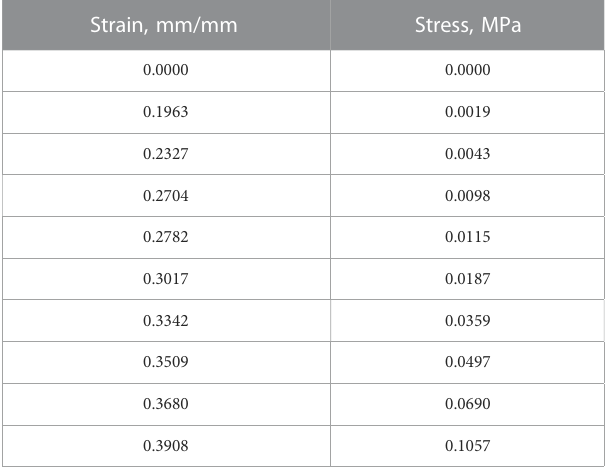
PDL: periodontal ligament. OGE: open gingival embrasure.